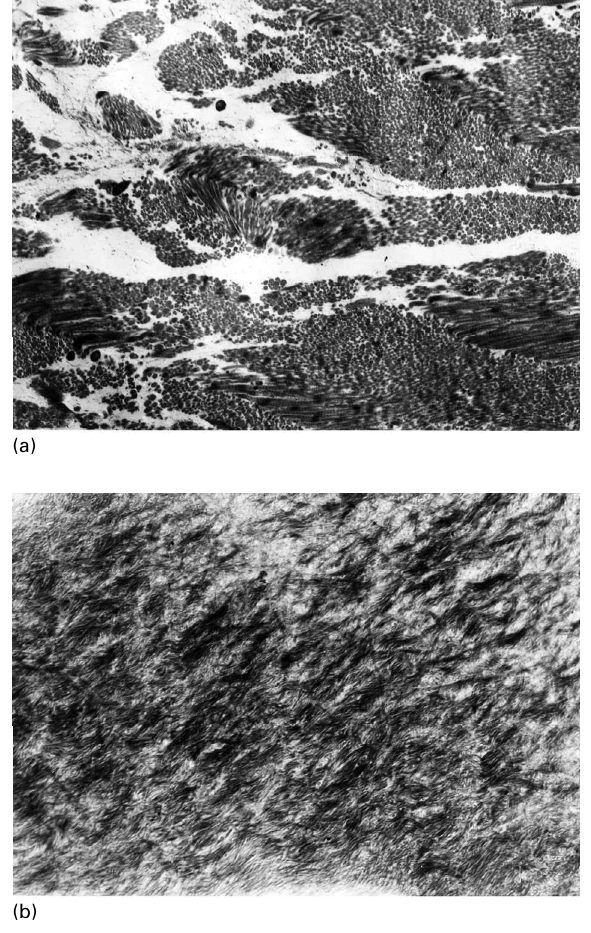
FIG. 2. (a) Transmission electron microscopy image of tibial cartilage treated with 15mg/ml of zymosan. Edema between the collagen fibrils package is shown. 12,000 ´ . (b) Transmis- sion electron microscopy image of tibial cartilage treated with 15mg/ml of zymosan plus 400mg/kg Spirulina. A normal arranbgement of collagen fibrils is observed. 12,000 ´